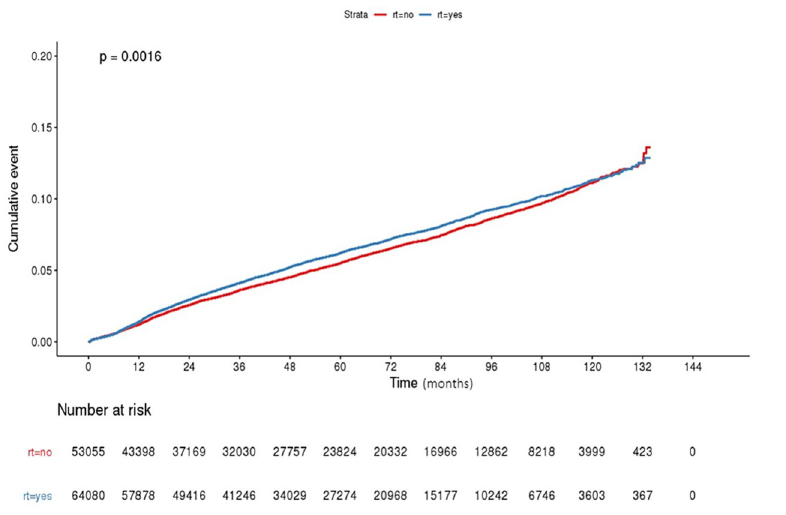
Fig 2. Cumulative incidence curves of hypothyroidism.